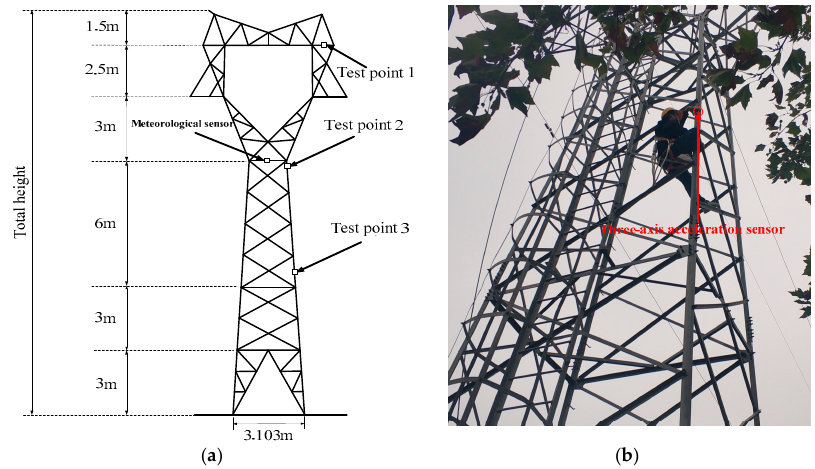
Figure 1. ZM ‐ 110 kV cat head tower: ( a ) transmission tower model; ( b ) installation of the monitoring device.